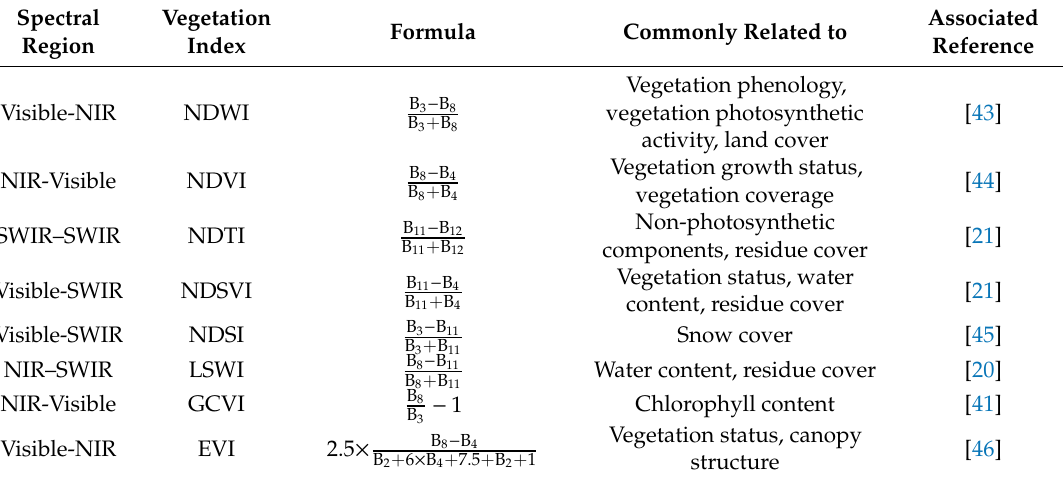
Table 1. A summary of vegetation indices in classification feature set, including their spectral regions, computational formulas, associated vegetation properties, and references.